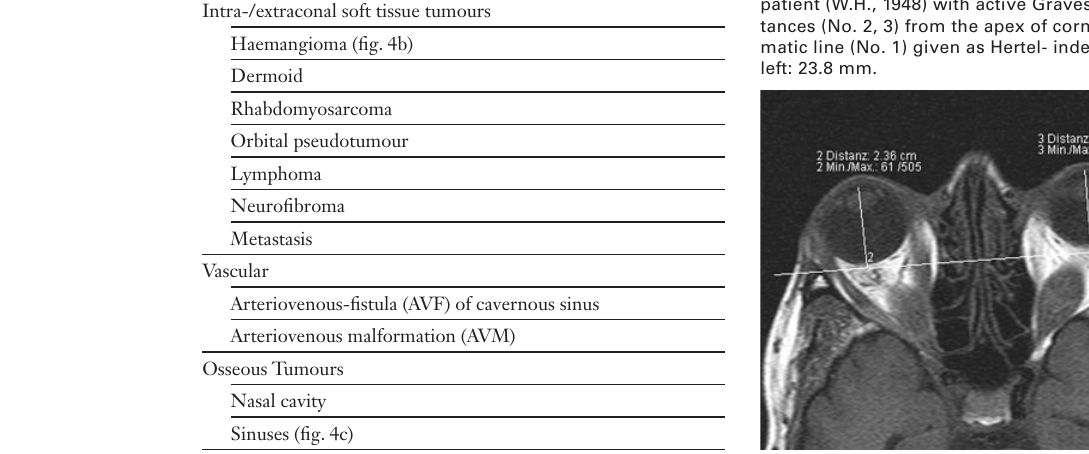
Differential Diagnosis of Graves’ orbito-